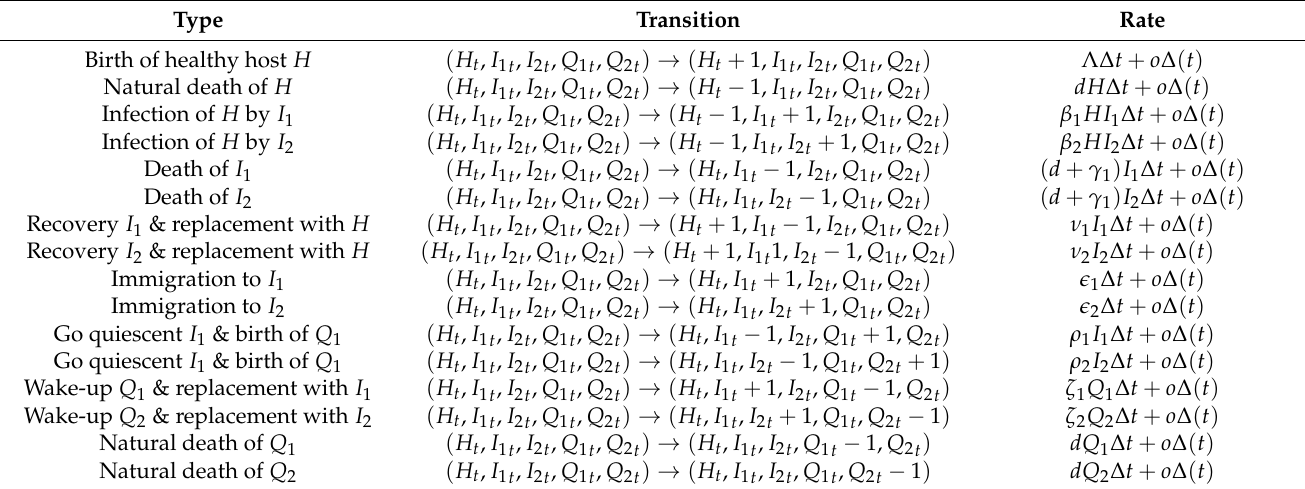
Table 1. Transitions rates for the quiescence model